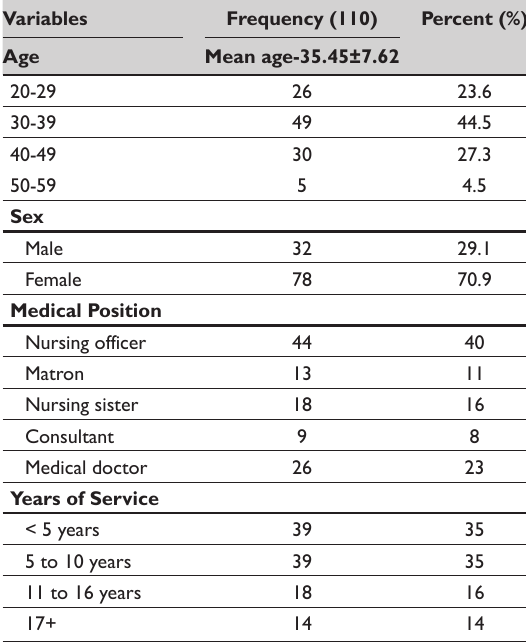
Table 2: Socio-Demographic Characteristics